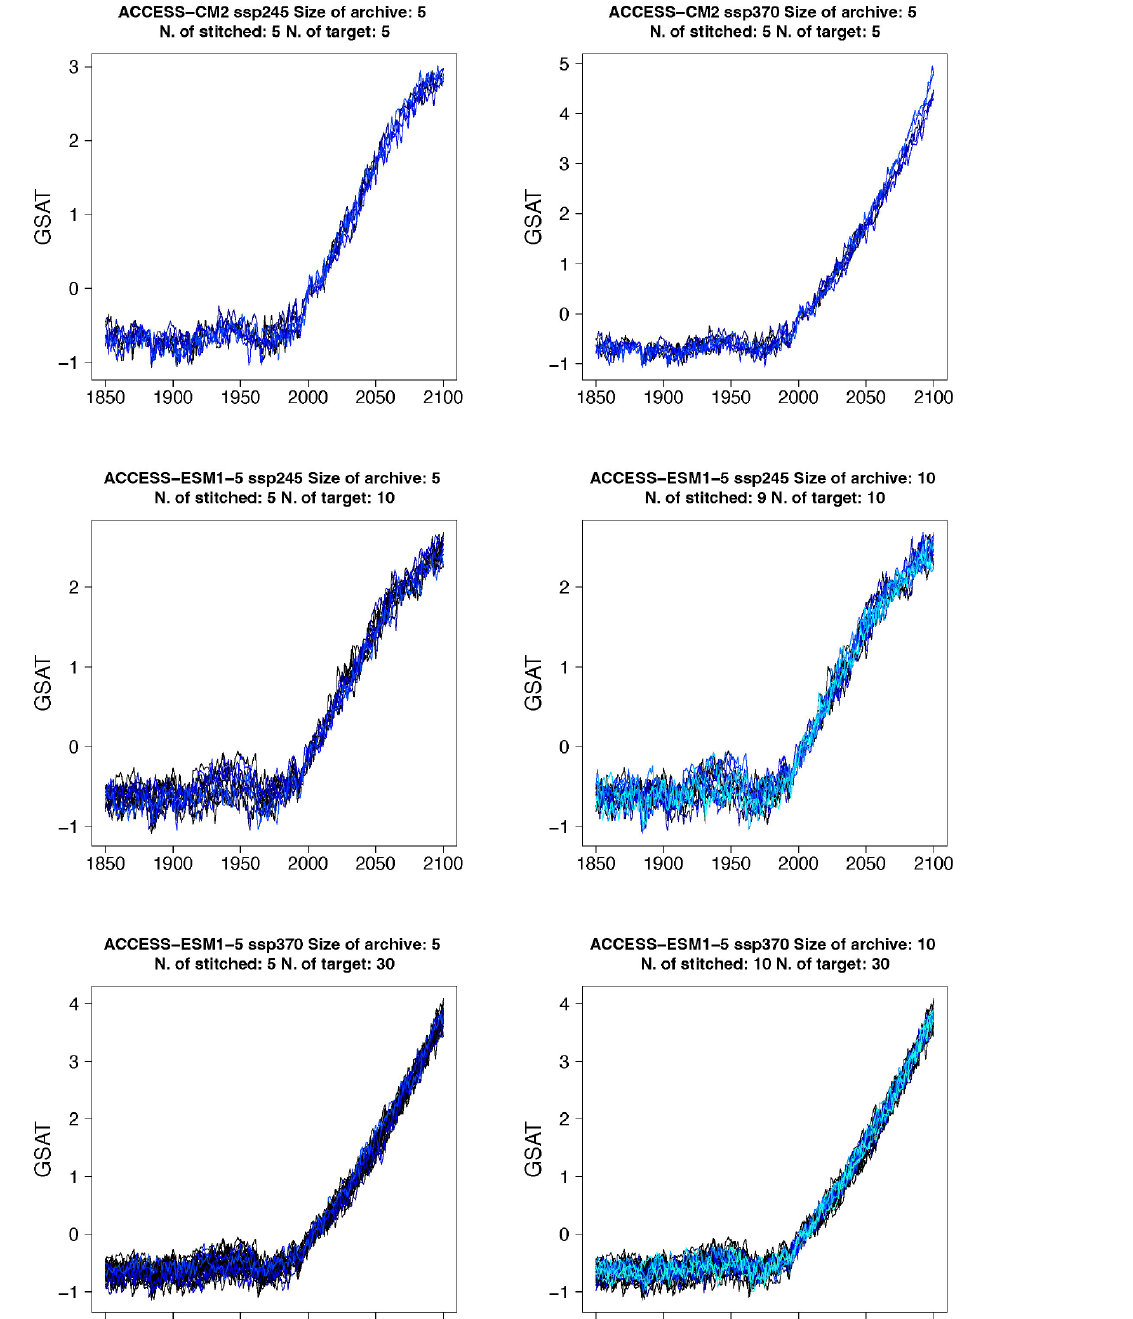
Figure E1. Examples of enriched ensembles of GSAT time series for ESMs in the PANGEO archive that have at least five trajectories available over the 21st century. As in the figures in Appendix A, warmer colors indicate a larger number of stitched trajectories in the figure, as the title also